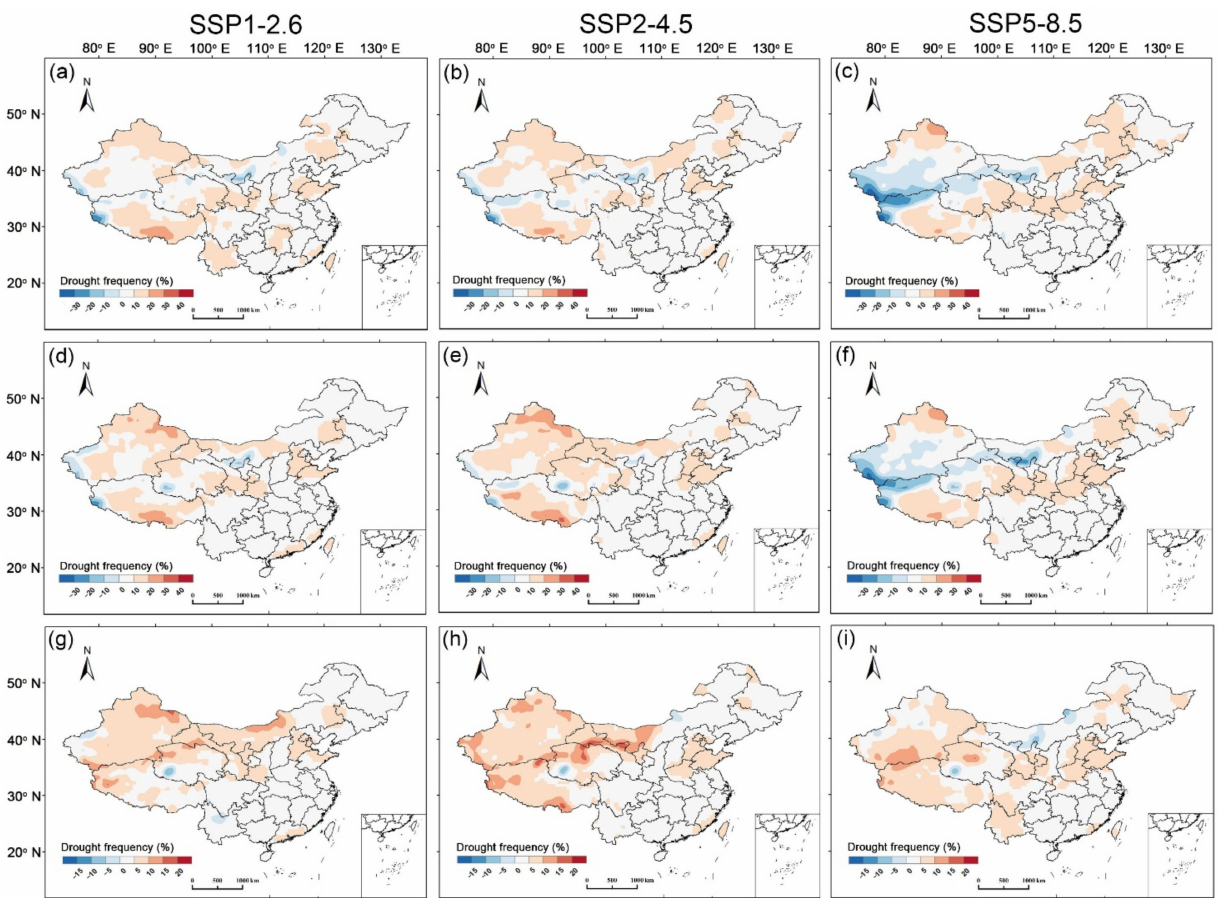
Figure 5. Spatial patterns of drought frequency change. ( a – c ) The 1.5 ◦ C global warming period relative to the reference period (1995–2014), ( d – f ) the 2.0 ◦ C global warming period relative to the reference period (1995–2014), and ( g – i ) the 2.0 ◦ C global warming period relative to the 1.5 ◦ C global warming period. Unit: